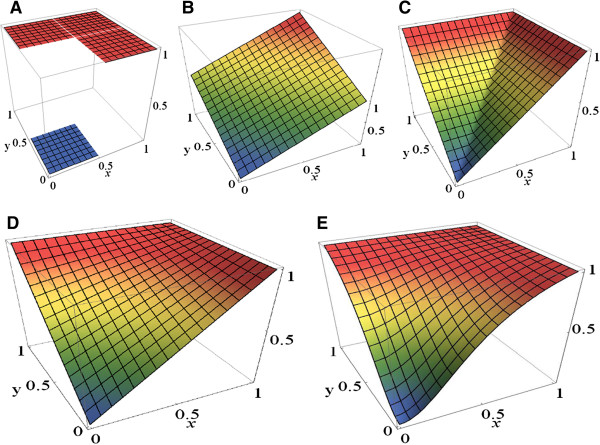
Interpolations of the Boolean function x OR y. Different panels show A) piecewise linear functions B) product-sum fuzzy logic C) min-max fuzzy logic D) Boole-Cubes E) Hill-cubes.